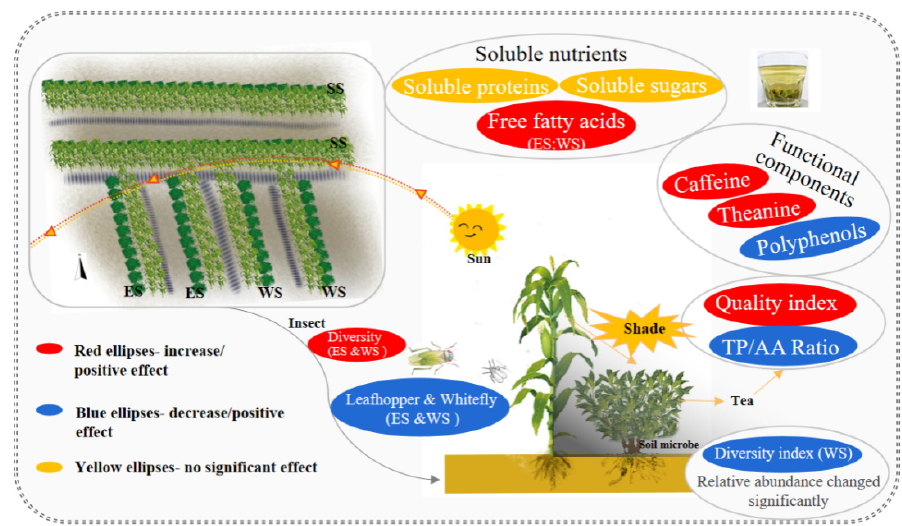
Figure 9. Effects of ecological shading by maize intercropping on foliar soluble nutrients and functional components of tea plants, and population abundances and community diversity of insect pests and soil microbes in tea plantation.